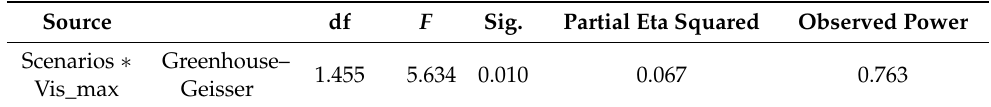
Table 10. Tests of within-subjects effects.